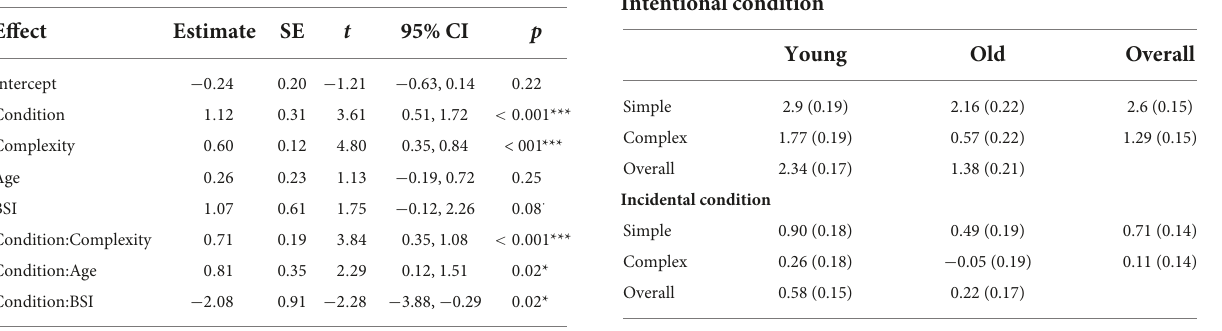
TABLE 3 Fixed effects from the LME model of rule learning d’ . TABLE 4 d’ mean and standard deviation per condition of learning, age group, and